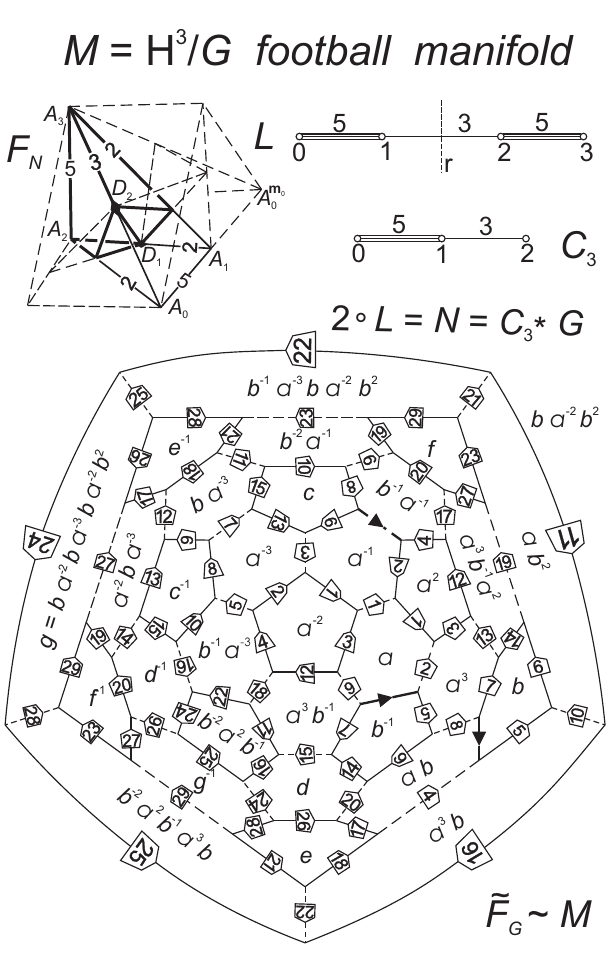
Figure 4. The hyperbolic football manifold for the Archimedean solid { 5,6,6 } and fullerenes.